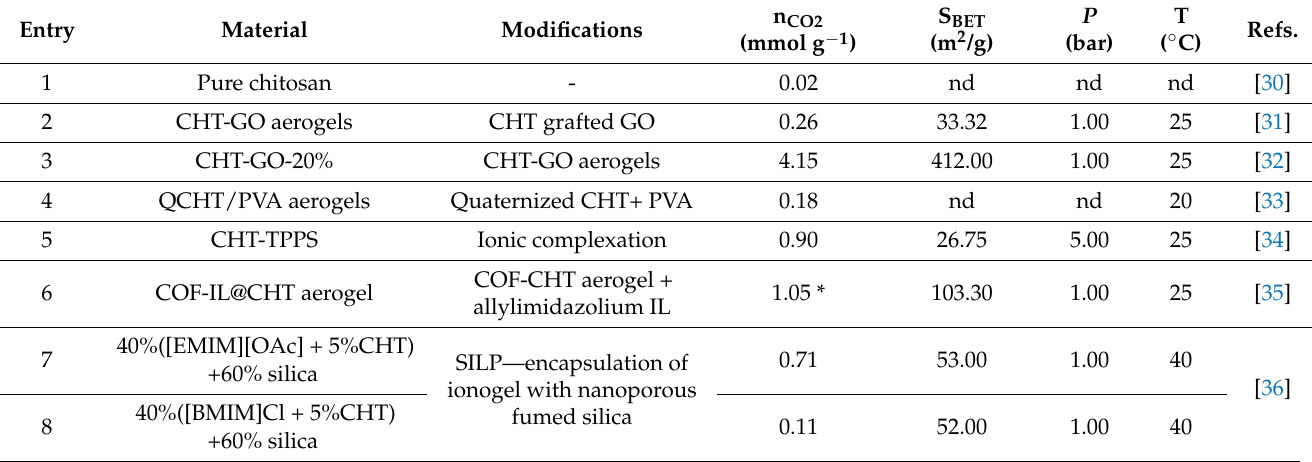
Table 1. Comparison of the CO 2 capture capacities and respective specific surface areas reported for different bio-based